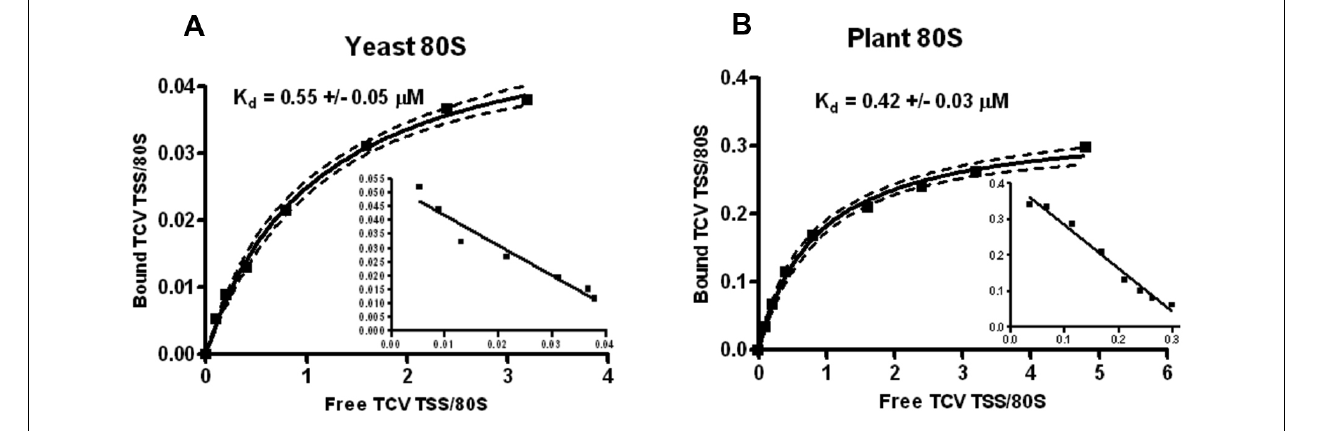
X -axis indicates the ratio of input (free)TSS to ribosomes. Scatchard plots are included for each saturation curve.To generate a saturation curve and to calculate K d values, each filter-binding experiment was conducted in